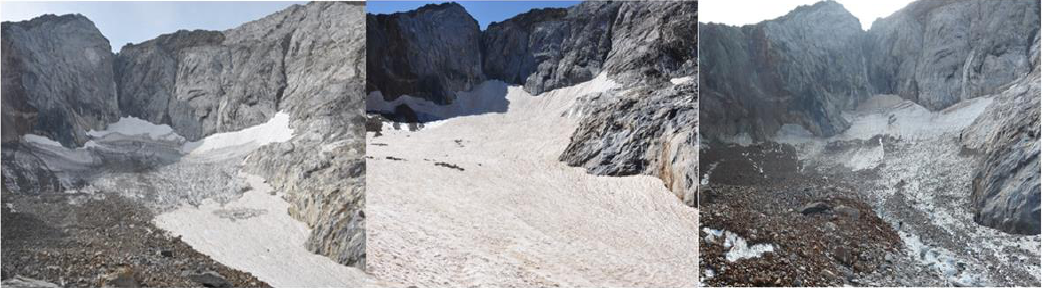
Figure 23. Detail of the Infierno Glacier. 3 September 2016 ( left ), 1 September 2018 ( center ), 30 August 2022 ( right ). Significant differences in the percentage of debris-covered glacier.